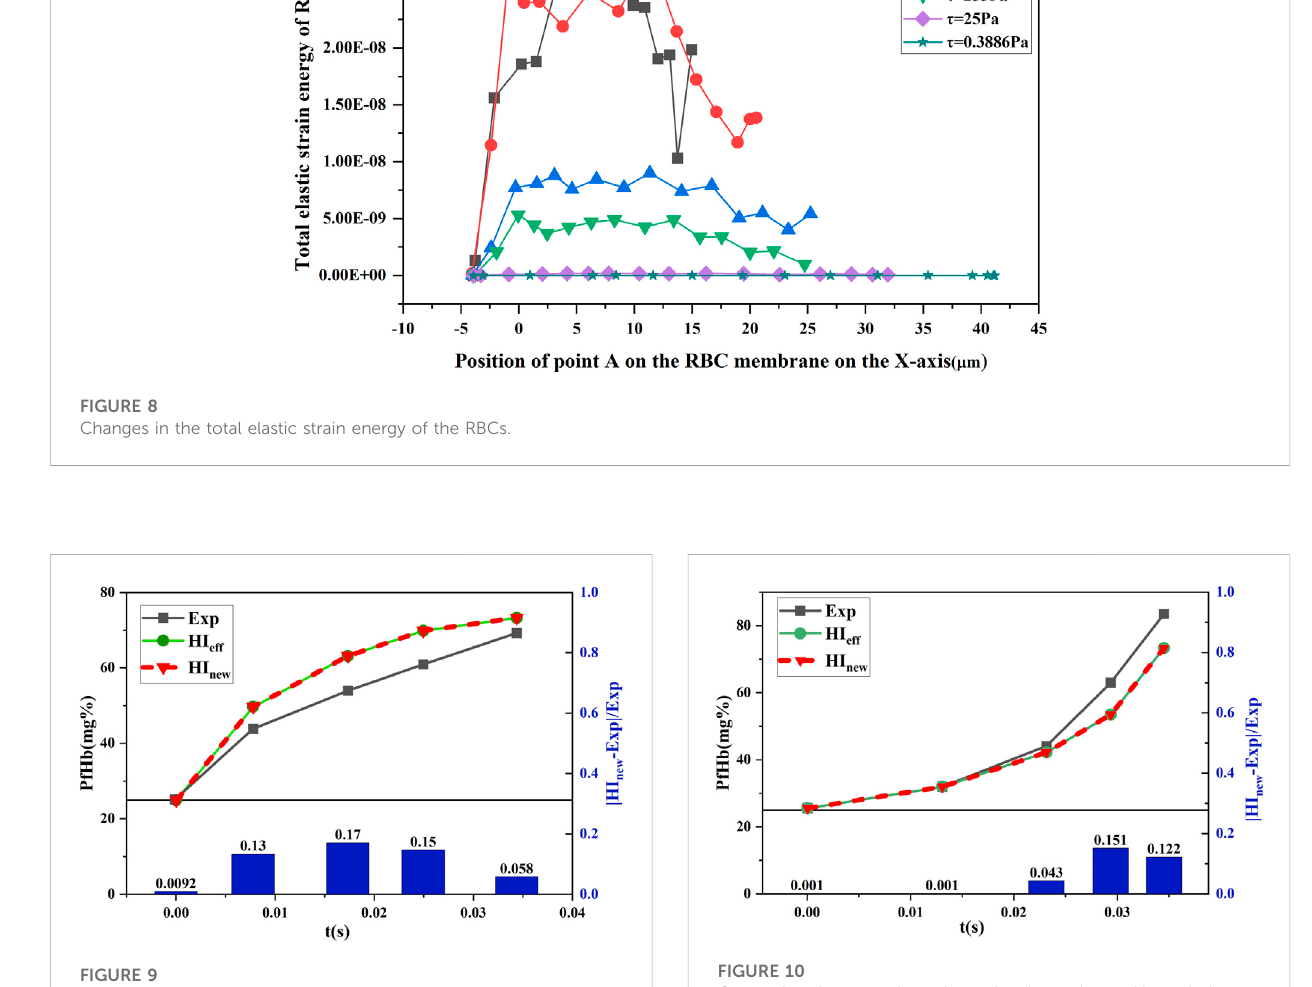
FIGURE 9 Comparison between the estimated and experimental hemolysis valueswiththedecreasingshearforceundertimeworkingconditions.